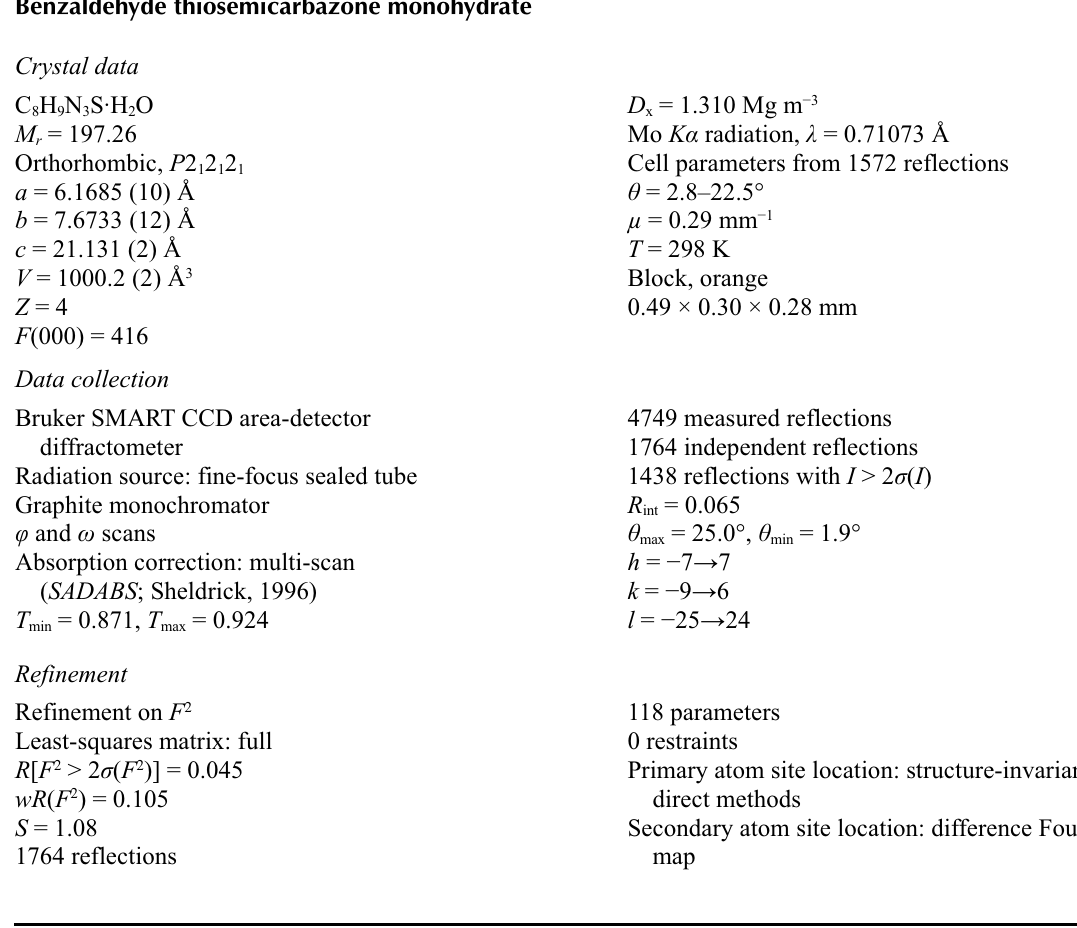
The content of asymmetric unit of the title compound showing the atomic numbering scheme and 30% probability displacement